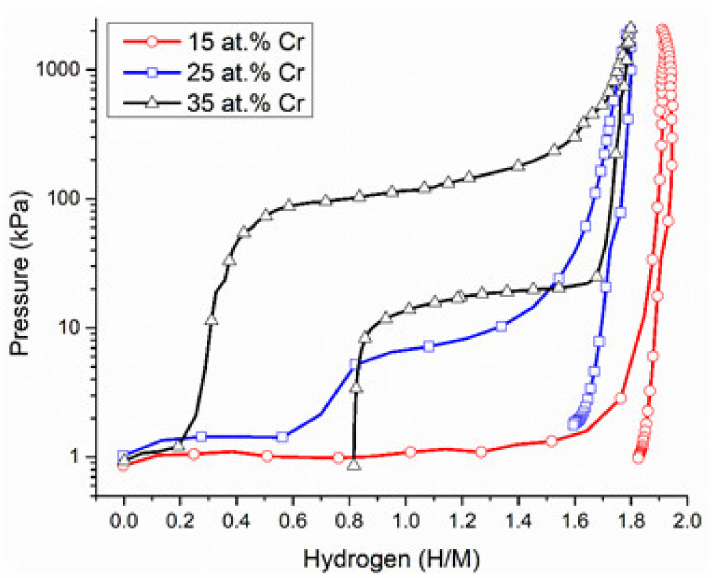
Figure 8. PCI absorption/desorption isotherms carried out at 24 ◦ C. The compositions are indicated in the